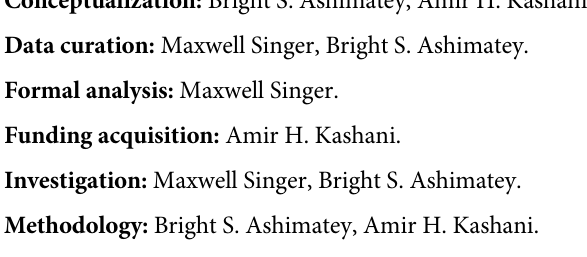
S1 Fig. Vessel area density (VAD) of control and diabetic subjects under gas conditions. Whiskers indicate highest or lowest point within 1.5 times the interquartile range from the upper or lower quartile. Diamonds indicate the mean. Stars indicate significance for pairwise comparison between conditions from the ANCOVA model based on Bonferroni adjusted p- value of 0.017. S2 Fig. Vessel skeleton density (VSD) and vessel diameter index (VDI) of control and dia- betic subjects under gas conditions using all vessel analysis in the superficial retinal layer. Whiskers indicate highest or lowest point within 1.5 times the interquartile range from the upper or lower quartile. Diamonds indicate the mean. Stars indicate significance for pairwise comparison between conditions from the ANCOVA model based on Bonferroni adjusted p- value of